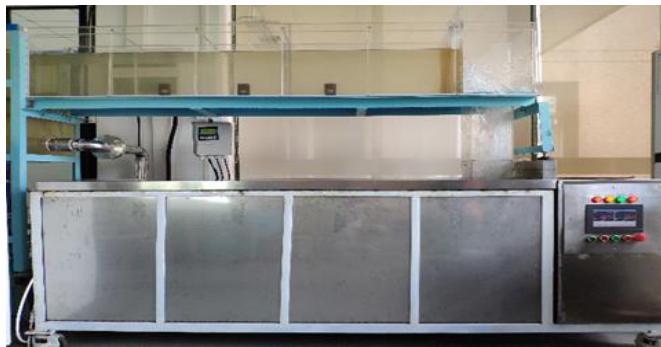
Figure 2. Physical image of multifunctional open channel hydraulics test equipment.